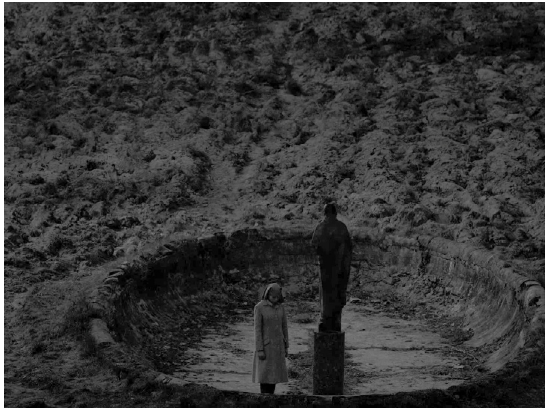
Figure 5. The darkened statue. Figure 6. Ida prays, “Forgive me.” Figure 6. Ida prays, “Forgive